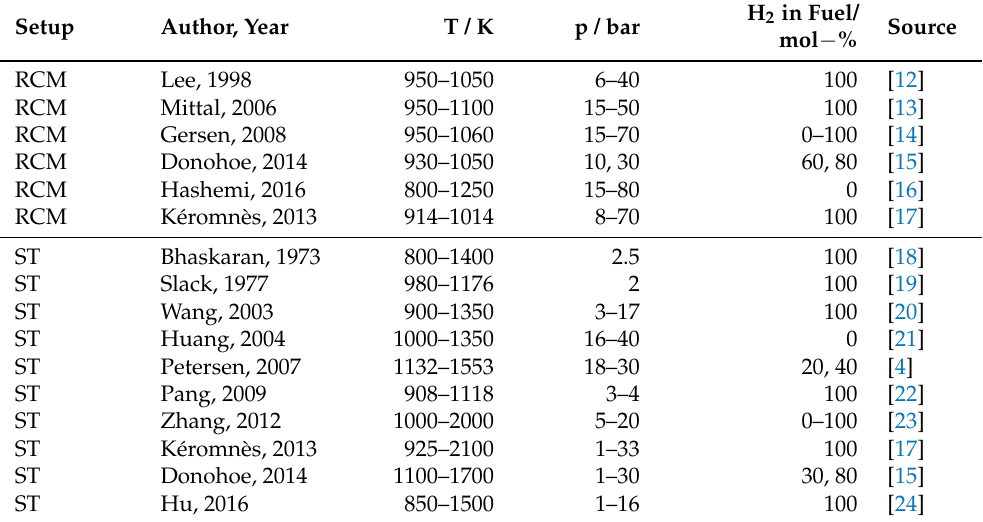
Table 1. Overview of the studies that investigated ignition delay times for CH 4 /H 2 mixtures. Column H 2 represents the H 2 mole fraction in the fuel mixture of CH 4 /H 2 . RCM: rapid compression machine and ST: shock